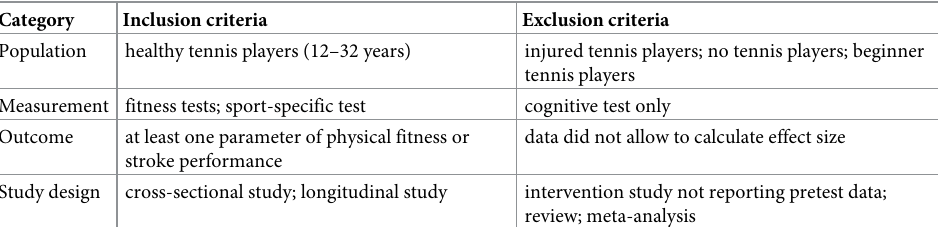
Table 1. Overview of the inclusion and exclusion